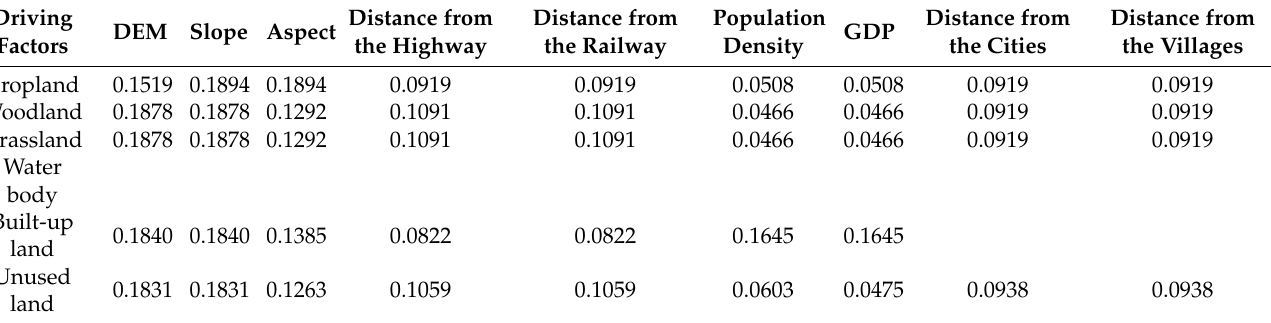
Table 2. Weights of the driving factors on land-use